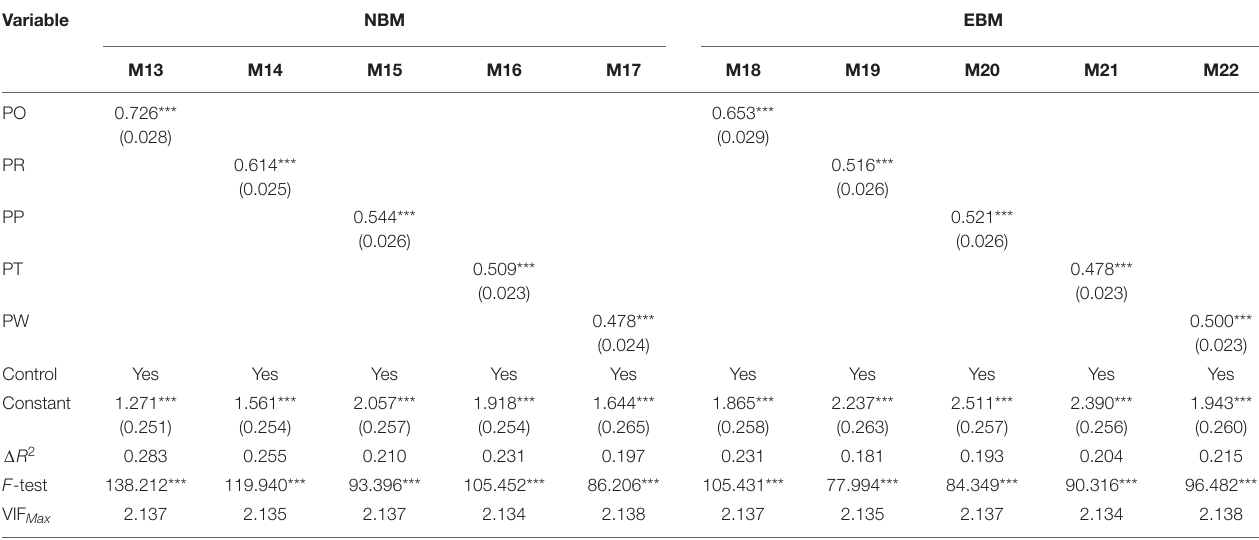
TABLE 4 | Alternative measures.